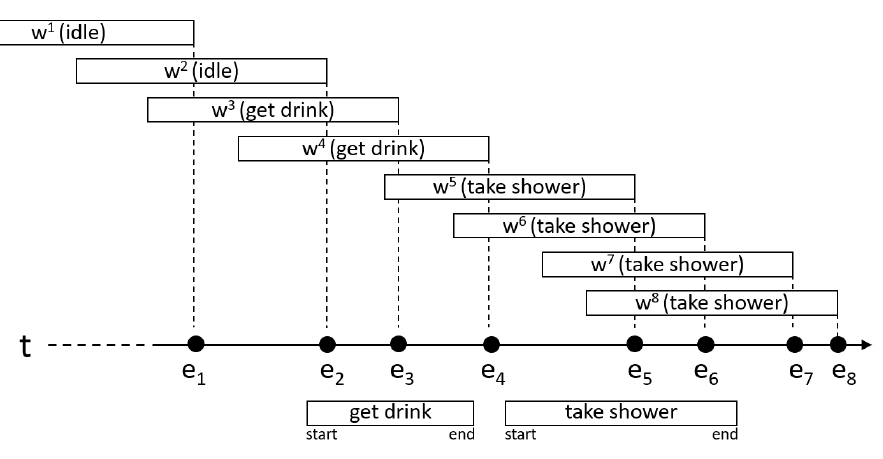
Figure 6. Example of an event-based activity